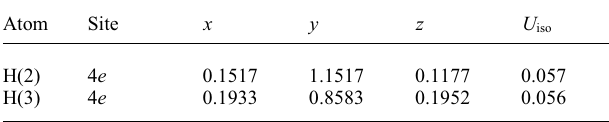
Table 2. Atomic coordinates and displacement parameters (in Å 2 )